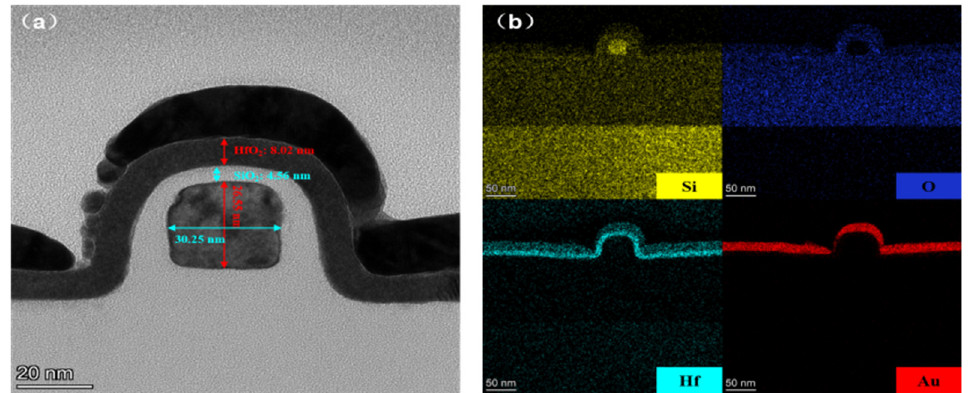
Figure 1. ( a ) TEM image of SiNW channel of the device. ( b ) EDS elemental mappings of Si, O, Hf and Au, respectively.